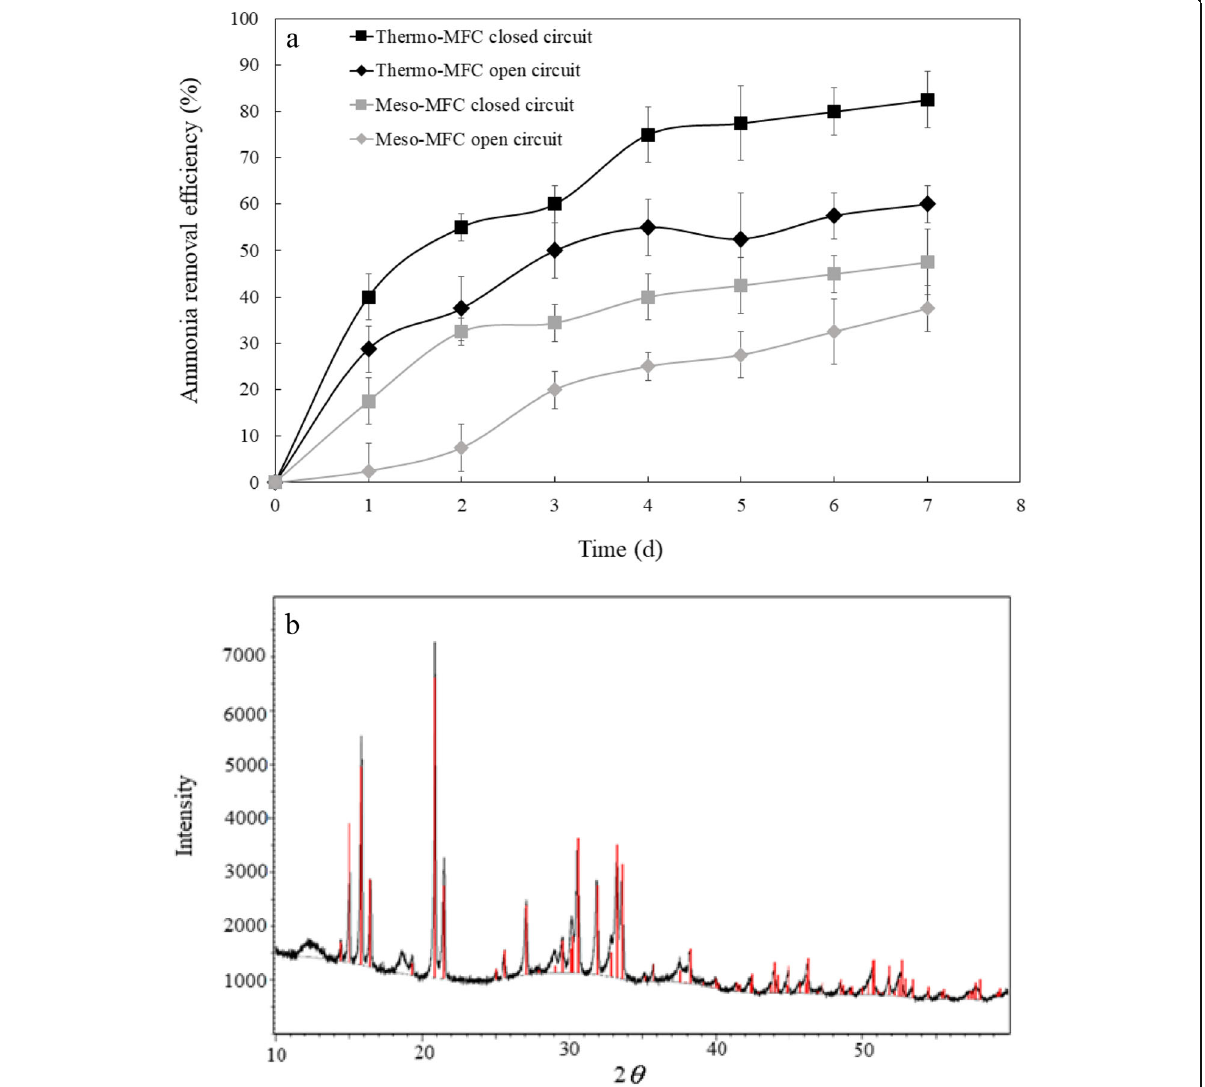
Fig. 3 Ammonia removal using thermo- and meso-MFC for open- or closed-circuit modes (bars indicate standard deviations) ( a ). The XRD pattern of pure struvite and recovery struvite ( b ). The red line represents pure struvite, and the black line represents collected